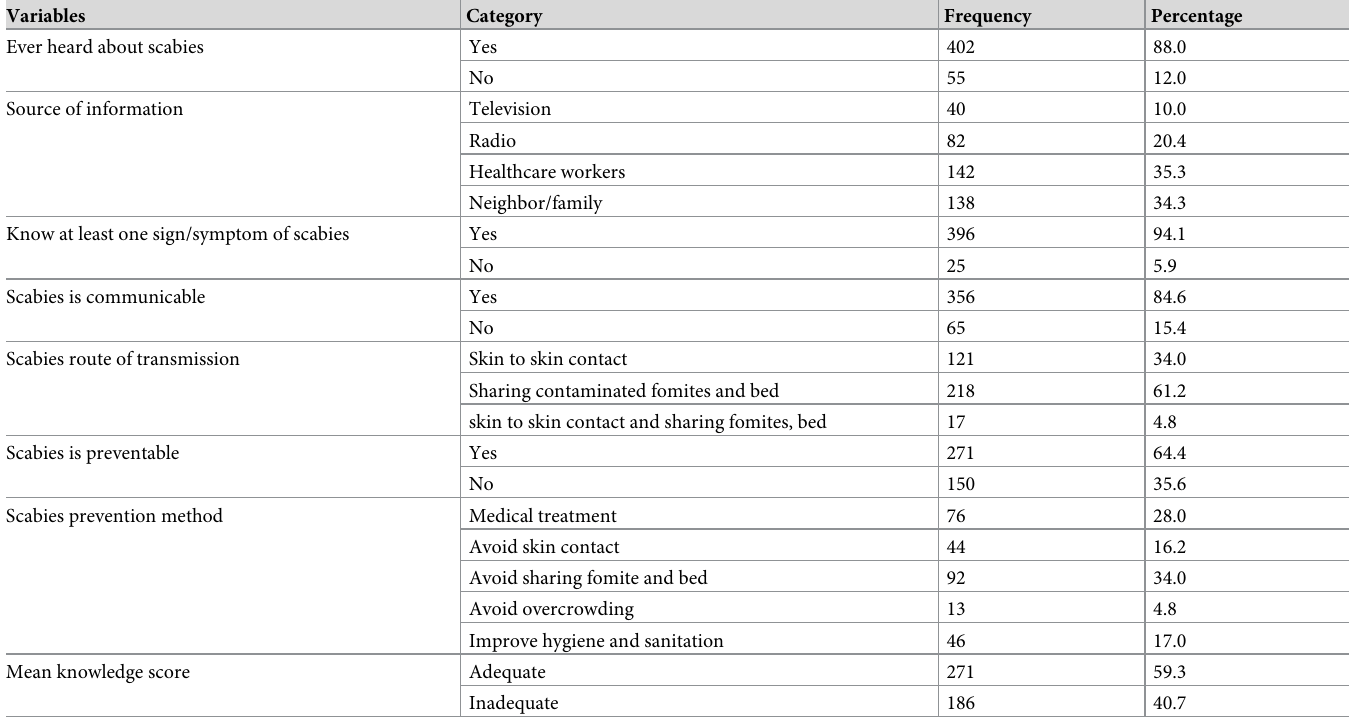
Table 4. Source of information and knowledge of caregivers about scabies, Meta Robi District,